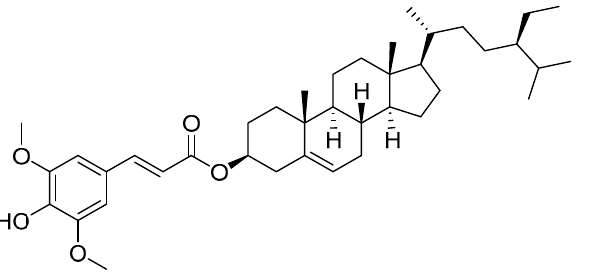
Figure 1. Structure of β -sitosteryl